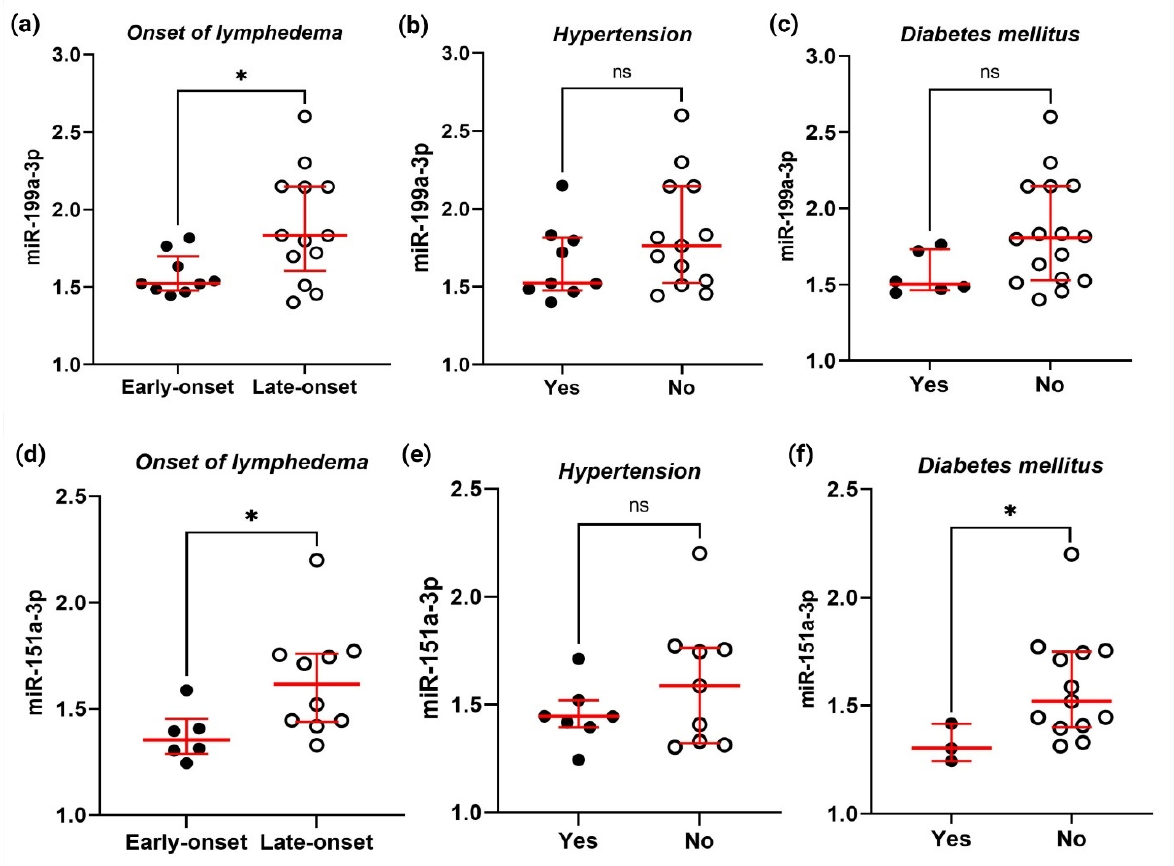
Figure 5. The relative expression of miR-199a-3p and miR-151a-3p in the BCRL group ( n = 23) stratified by the onset of lymphedema, hypertension, and diabetes mellitus status. Relative expression of miR-199a-3 by qPCR analyzed according to ( a ) onset of lymphedema, ( b ) hypertension, and ( c ) diabetes mellitus status. Relative expression of miR-151a-3p stratified by ( d ) onset of lymphedema, ( e ) hypertension, and ( f ) diabetes mellitus. Samples were measured in triplicate and results are shown as a dot plot of the relative normalized expression of the miRNA of interest (2 −∆∆ Ct ). * p -values were calculated by Mann–Whitney test ( p < 0.05), with ns denoting a non-significant difference. The horizontal bars represent pairwise comparison between respective variables and dichotomous outcomes, blue lines represent the median and error bars indicate the IQR of each group.